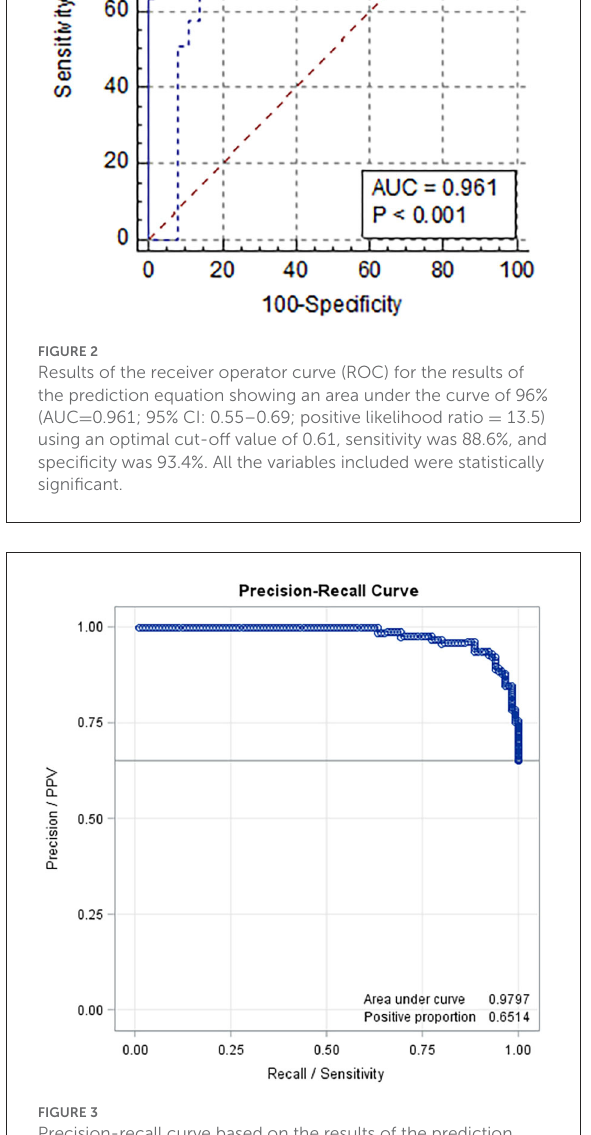
TABLE 1 Results from the confusion matrix on LESpred (estimated using the 0.5 cutoff on the results from the prediction equation) tested against LESeval (clinically evaluated lesion) indicating the sensitivity (proportion of true positive cases that were correctly identified), the specificity (proportion of true negative cases that were correctly identified), the accuracy (proportion of correctly identified cases as both true positive and true negative), the precision (proportion of correctly identified true positive cases belonging to the actual (true positive and false positive) group), and the misclassification rate of the proposed method.